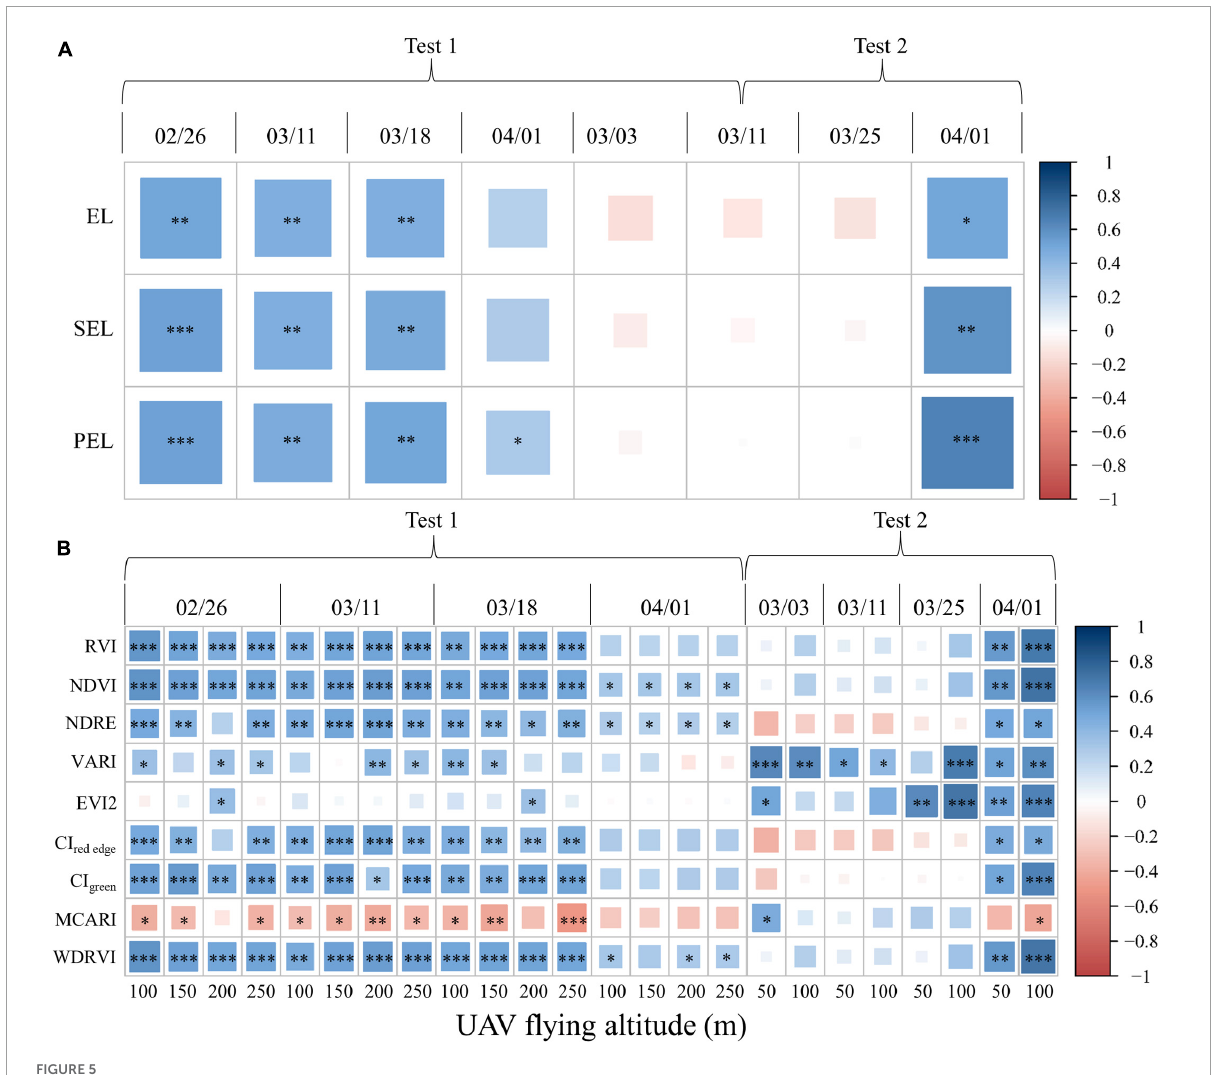
FIGURE5 Impact of different RCMs and UAV-FAs on yield prediction: (A) Pearson correlation coefficient between rice yield and CI green based on three RCMs in Test 1 and Test 2; (B) Pearson correlation coefficient between rice yield and VIs at different UAV-FAs in Test 1 and Test 2 ( ∗∗∗ , ∗∗ , and ∗ represent the significant correlation at the 0.001, 0.01, and 0.05 levels,